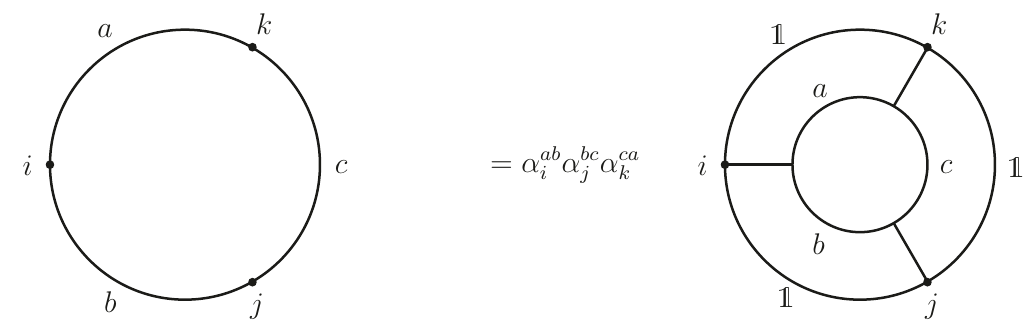
Figure 22 . Two equivalent ways of computing a boundary three-point function. The α coefficients are sensitive to both the normalization choice for boundary fields and the F -matrix gauge used in defect manipulations.